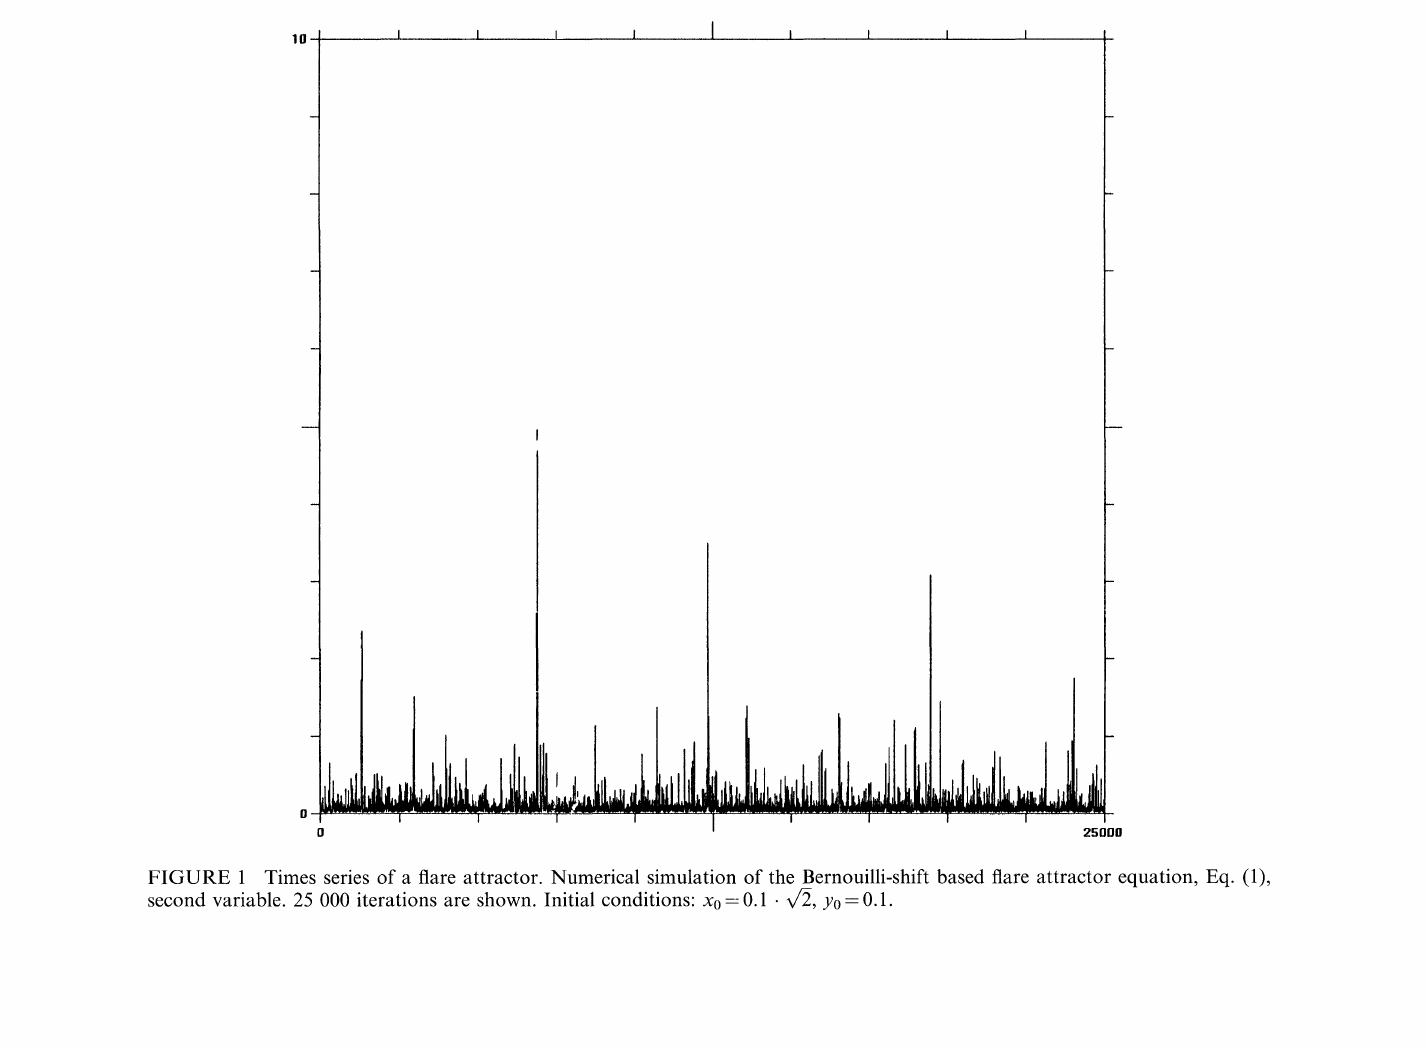
FIGURE Times series of a flare attractor. Numerical simulation of the Bernouilli-shift based flare attractor equation, Eq. (1), second variable. 25 000 iterations are shown. Initial conditions: x0-0.1 x/, Y0